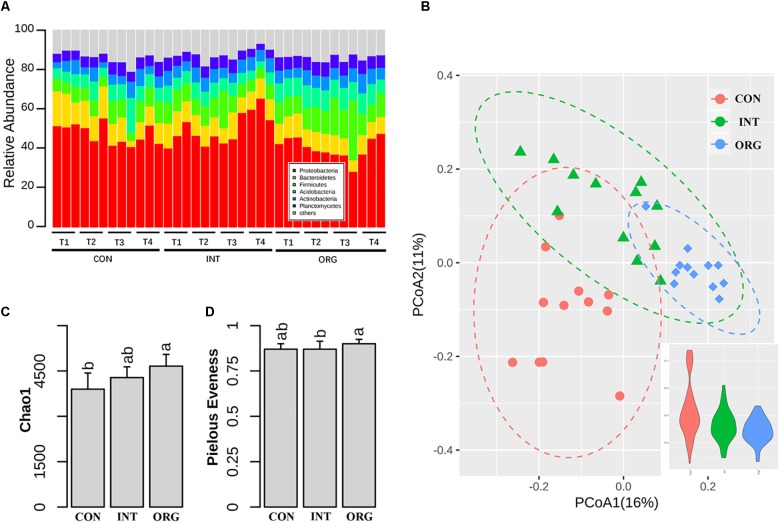
Relative abundance of different phylum (A), PCoA analysis of microbial community and variation within treatments (B), species richness index (C), and evenness index (D) in the rhizosphere of pepper seedlings in soils from the organic (ORG), integrated (INT), and conventional (CON) farming systems during the four sampling periods, i.e., T1 (27 days after sowing), T2 (31 days after sowing), T3 (35 days after sowing), and T4 (38 days after sowing). Significant differences are indicated by different letters.